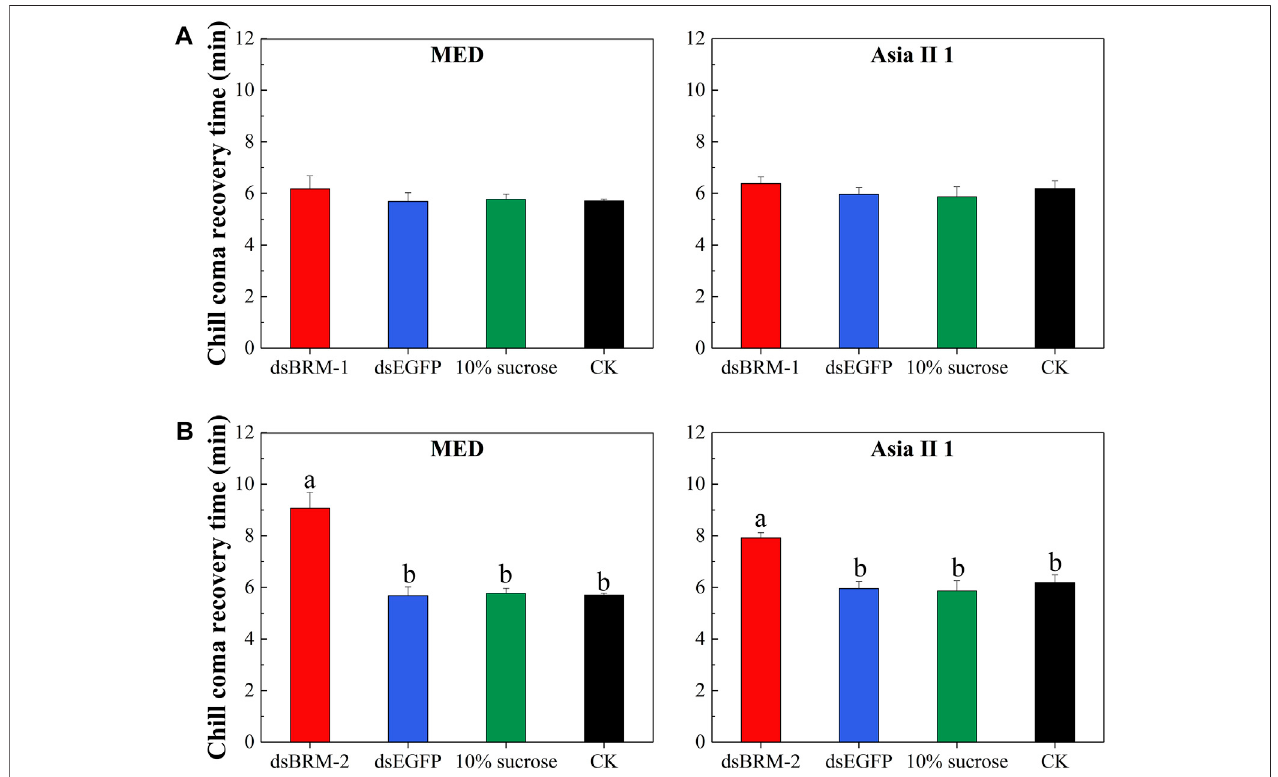
FIGURE 9 | Mean chill coma recovery time (TRC) after double-stranded RNA (dsRNA) feeding in white fl ies. Compared with the controls (white fl ies untreated (CK), given dsEGFP, or 10% sucrose), TRC for adults feeding with dsBRM-2 (B) was signi fi cantly increased. Although the TRC of MED and Asia Ⅱ 1 increased after silencing Bt-BRM-1 (A) , there was no statistically signi fi cant difference. Moreover, cold resistance of the two cryptic species was reduced differently after interfering with the remodelers(detailsarelistedin SupplementaryTableS4 ).Thedataarepresentedasthemean±SE; n =200.Barswithdifferentlowercaselettersaresigni fi cantly different at p <